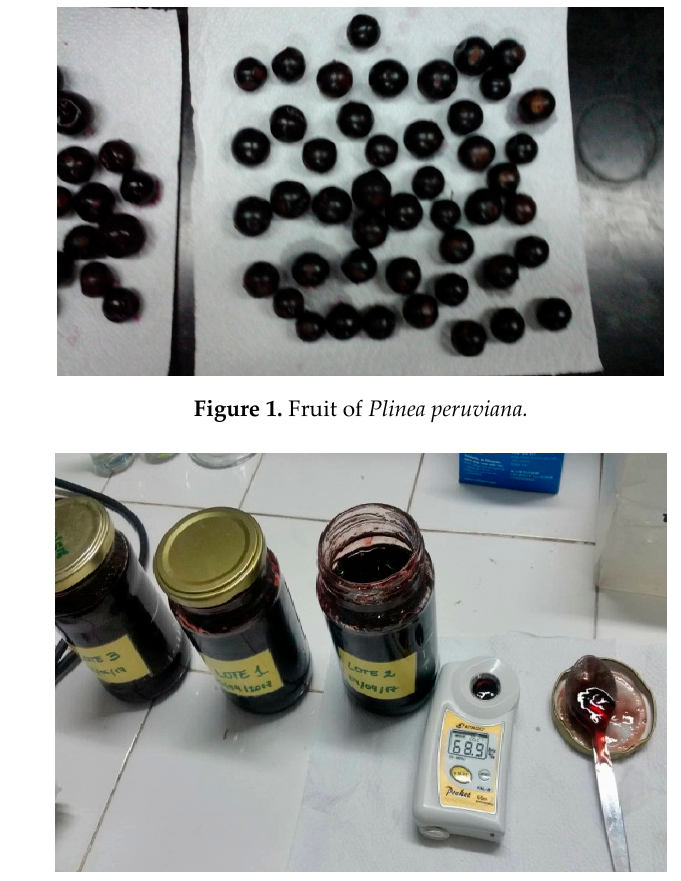
Figure 2. Batches of Yvapur ũ